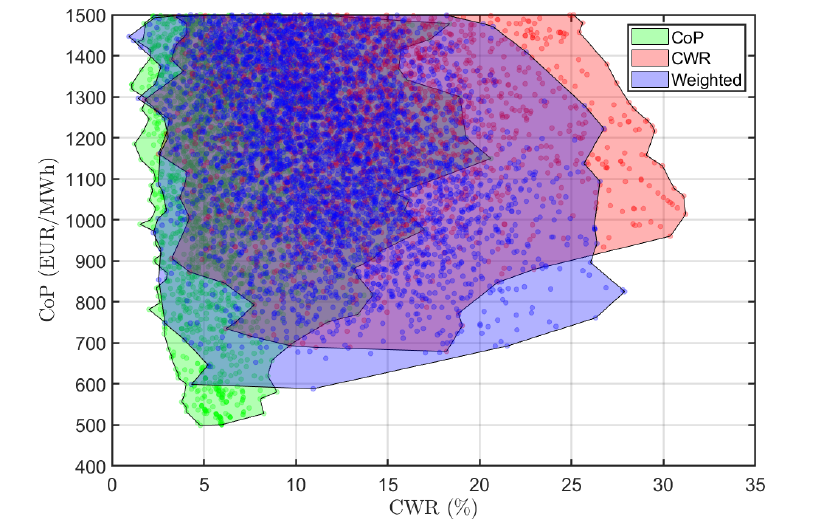
Figure 12. Ensemble of the three optimisations (CoP-driven, CWR-driven and weighted), with shaded areas encompassing each one of the three populations.